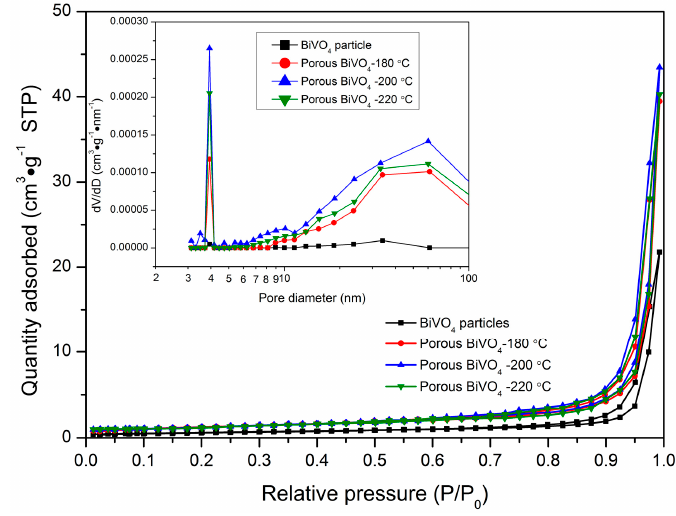
Figure 3. N 2 adsorption-desorption isotherms of BiVO 4 particles and BiVO 4 samples prepared at various hydrothermal temperatures. The inset is the corresponding BJH pore size distributions. Table 1. BET specific surface area and BJH pore volume of all of the as-prepared samples.